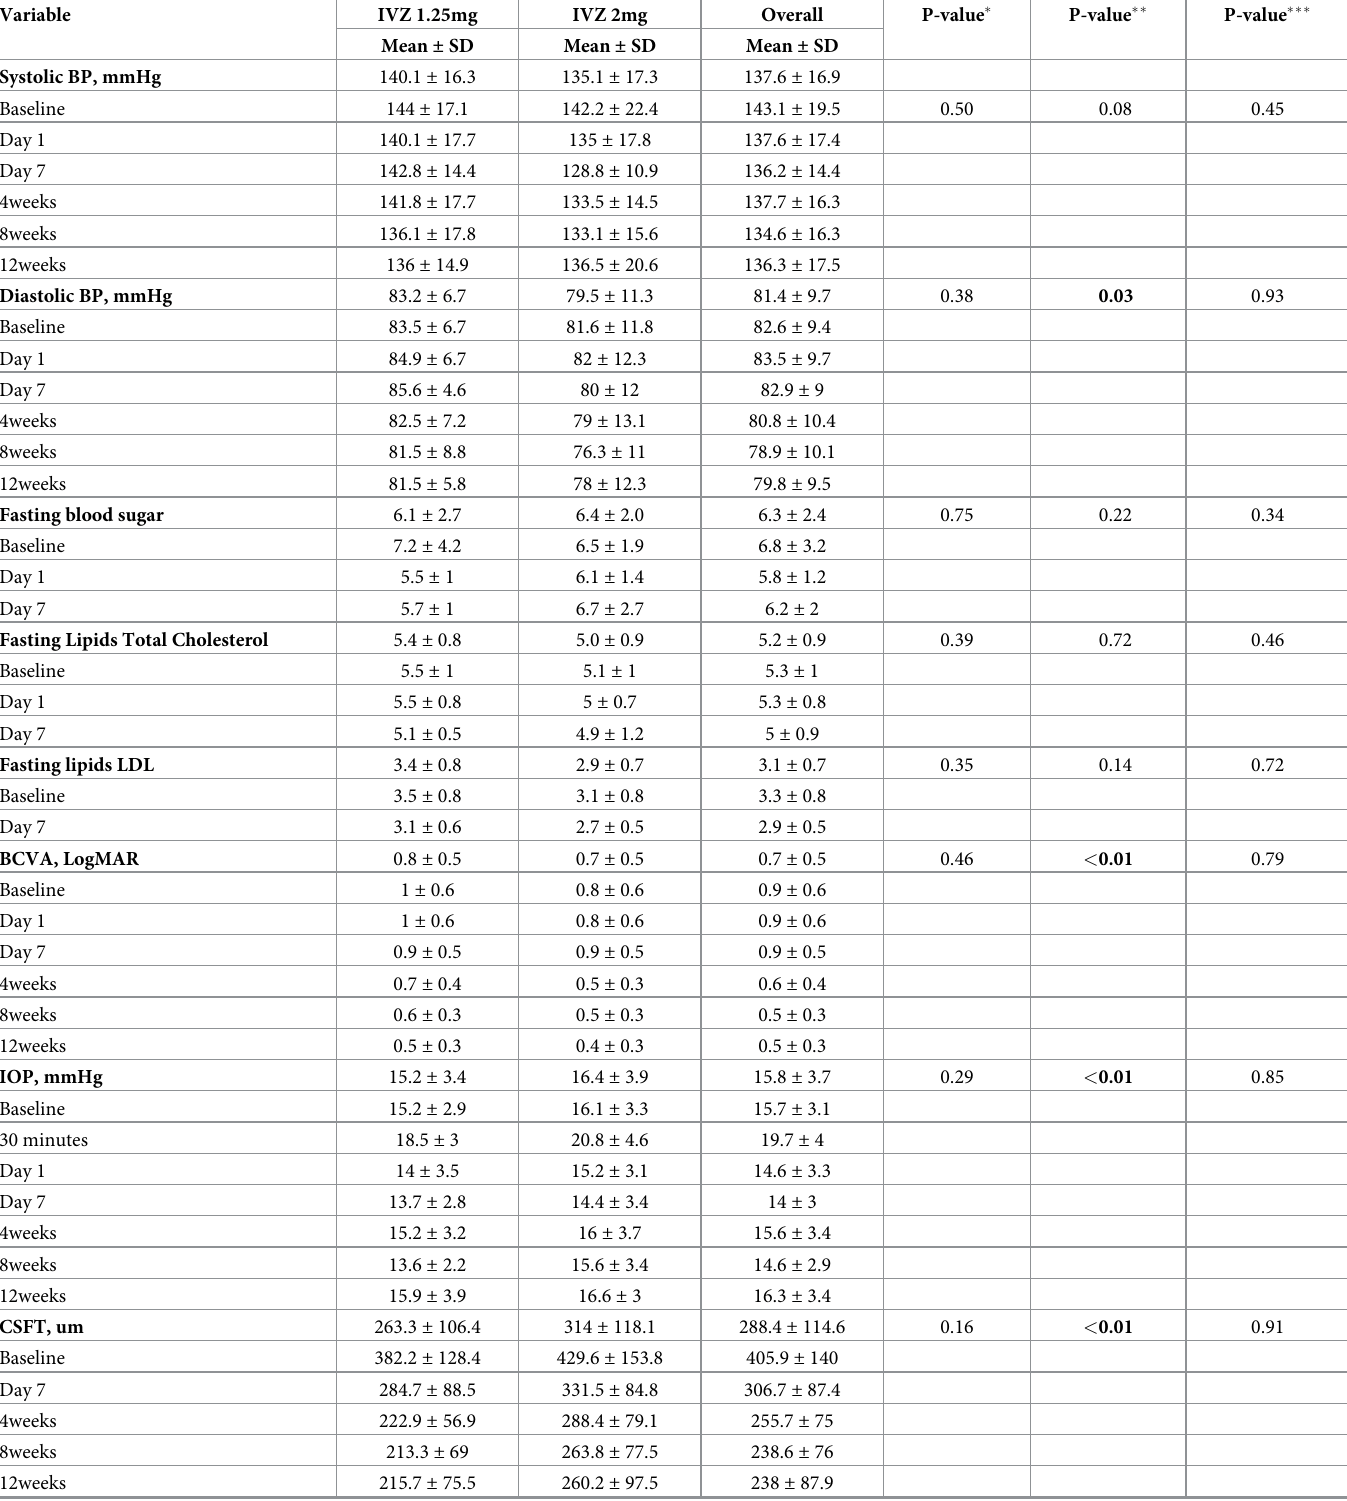
Table 3. Comparison of changes in continuous variables between IVZ dose at baseline and up to 12 weeks visit using Repeated-Measures ANOVA with nesting.